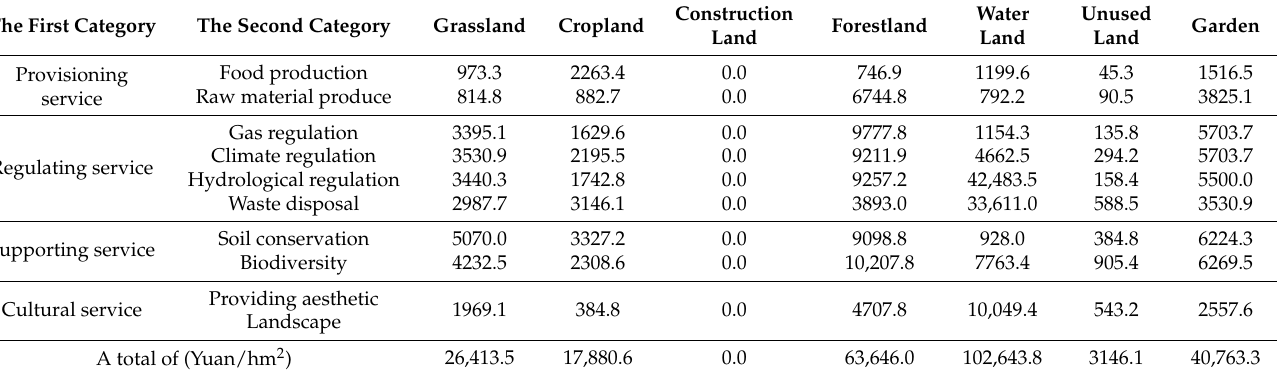
Table 1. Ecosystem services value coefficients in the Wuling Mountains (yuan/hm 2